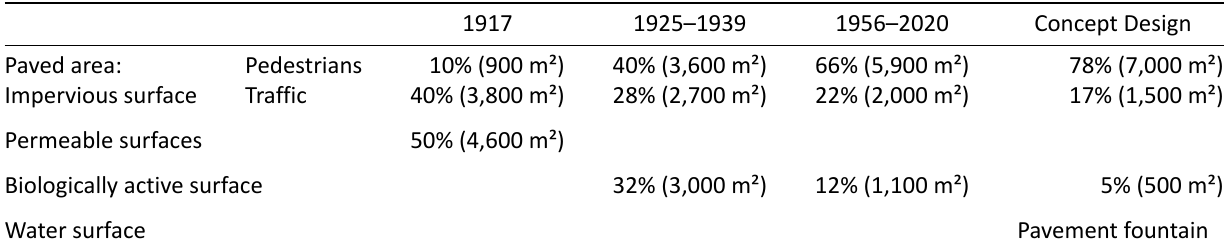
Table 5. Old Market Square, Lodz: Percentage share of different surfaces in the area of the